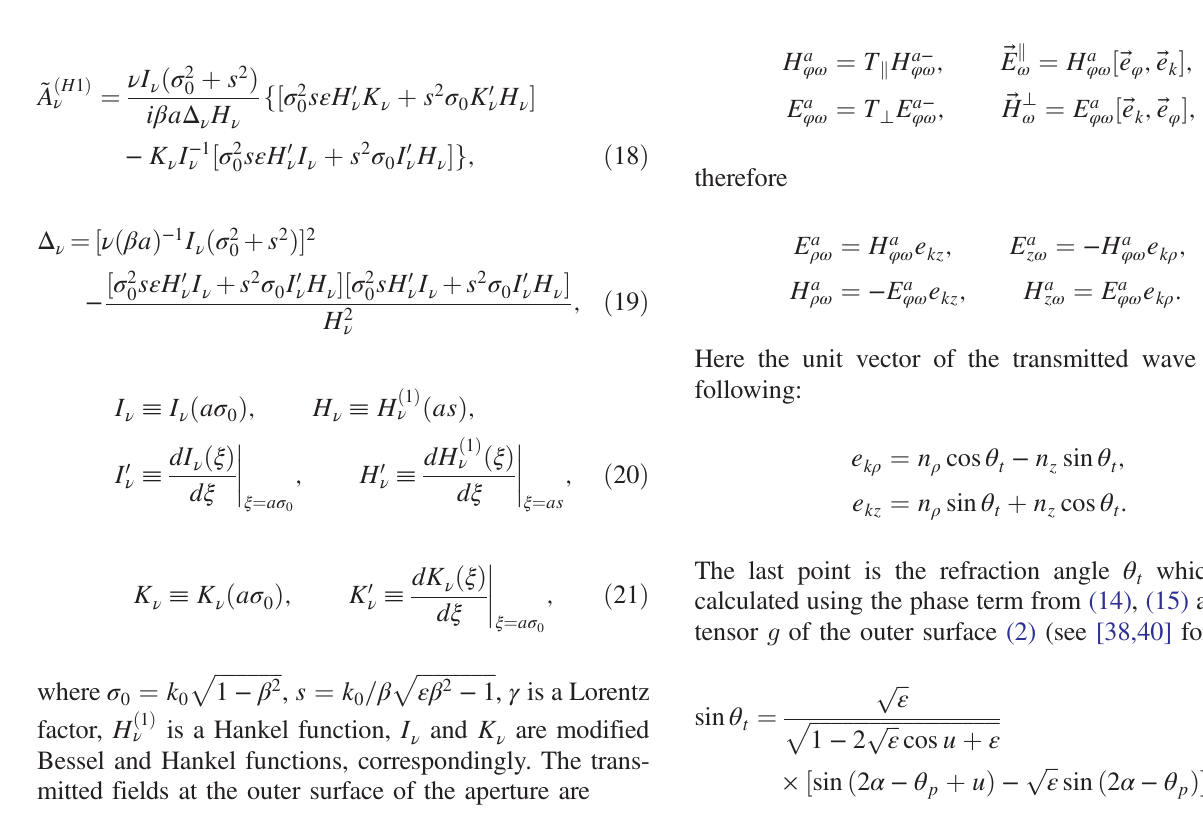
, z is normalized by f ) for max f ¼ 23 . 9 cm, a ¼ c= ω ¼ 0 . 047 cm, max ¼